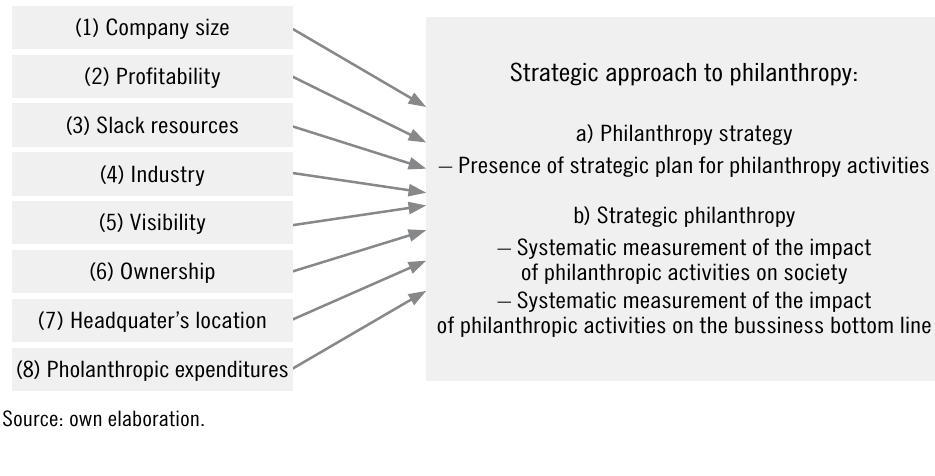
Figure 1. Conceptual